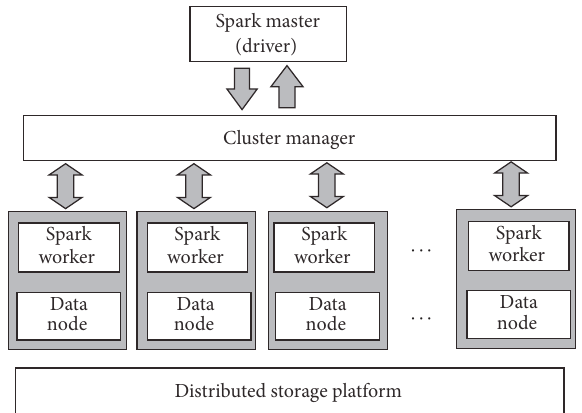
Figure 1: SPARK distributed architecture.